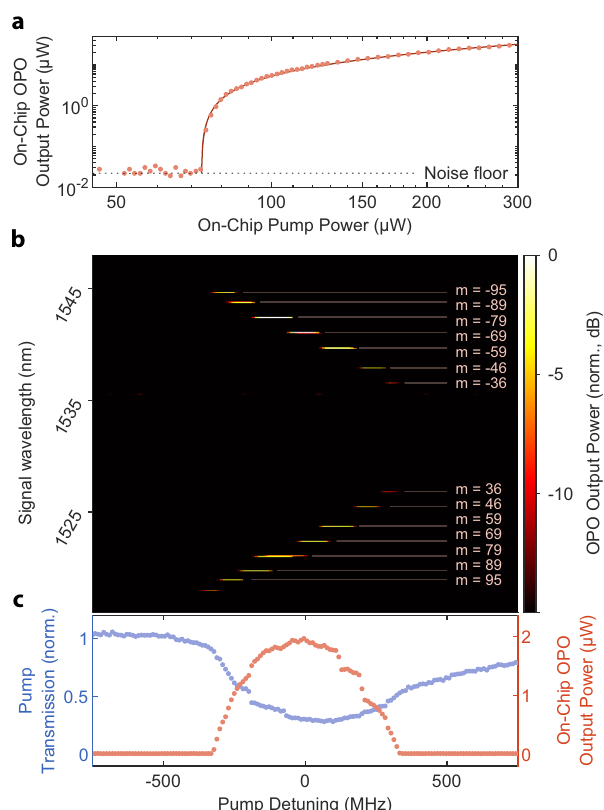
Fig. 3 Optical parametric oscillation. a Threshold characterization of the OPO, we increase the 765.8 nm laser power until the oscillation begins at a threshold of around 73 μ W; above it, the OPO power output follows a square-root relation. Dotted line represents detection noise fl oor. b Tuning of non-degenerate OPO emission with pump wavelength, at a pump power of 250 μ W. We can select OPO signal/idler pairs spanning 1537 – 1545 nm (1527 – 1519 nm) as the pump is swept over 650 MHz. c SH resonance lineshape (blue points) aligned with the OPO response (red points) collected above threshold (250 μ W) shows steps corresponding to switching between signal/idler